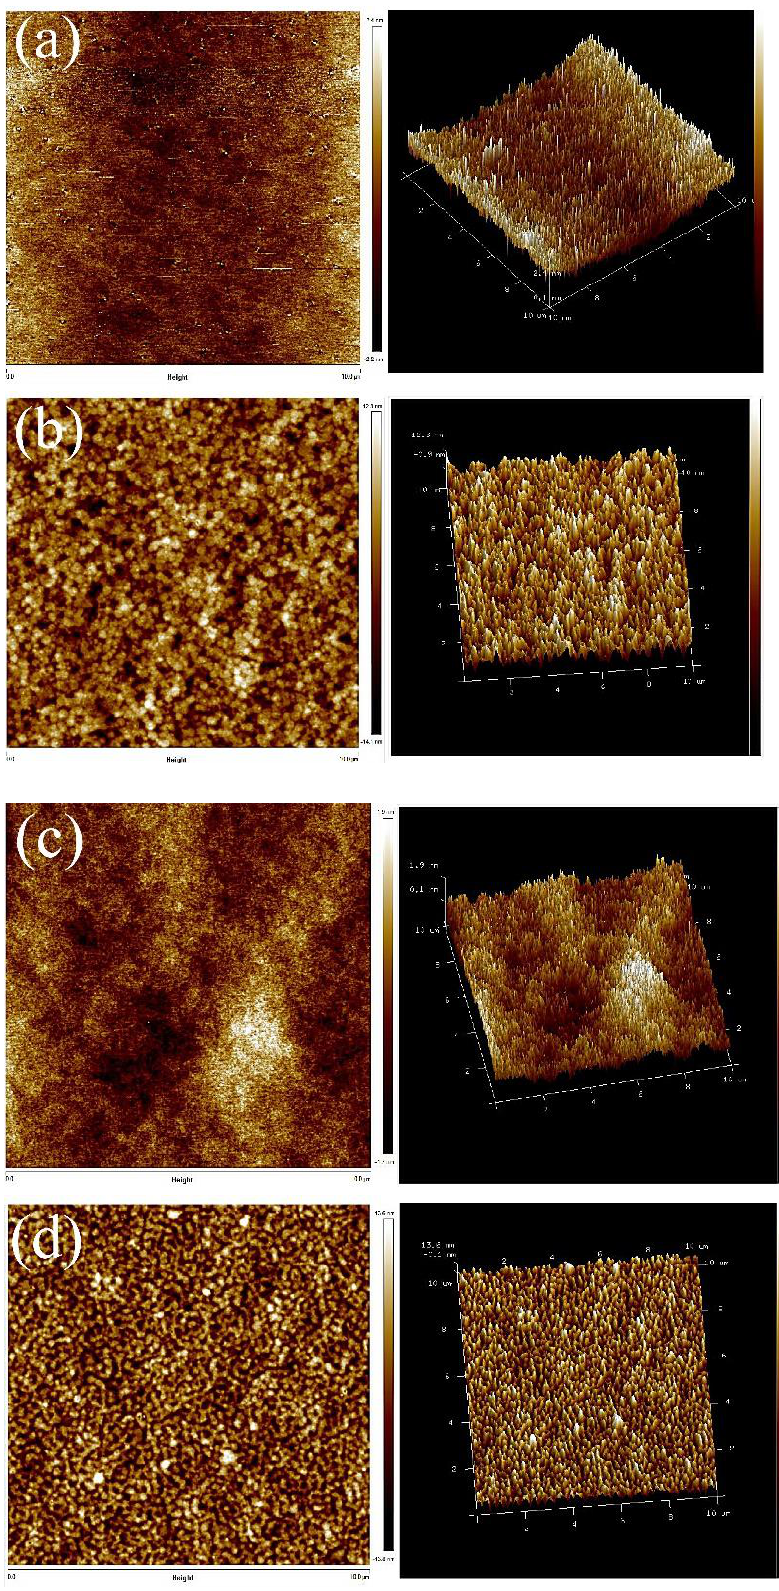
Figure 5. Atomic force microscope (AFM) scanned images: ( a ) PBA-1,3-BDO, ( b ) PBA-1,4-BDO, ( c ) PTMG-1,3-BDO, ( d )